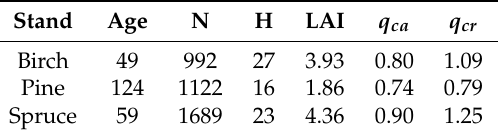
Table 1. Description of three forest stands in the Järvselja database [7]. Stand Age N H LAI q ca q cr